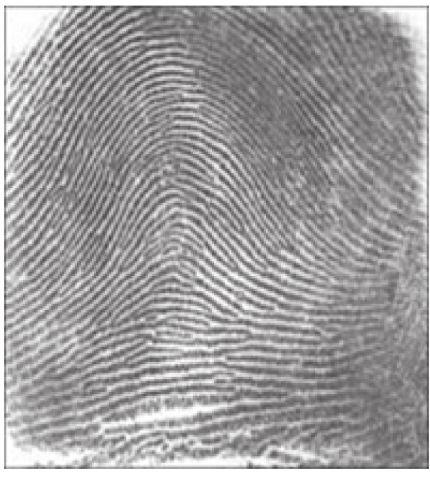
Figure 2: The arch.